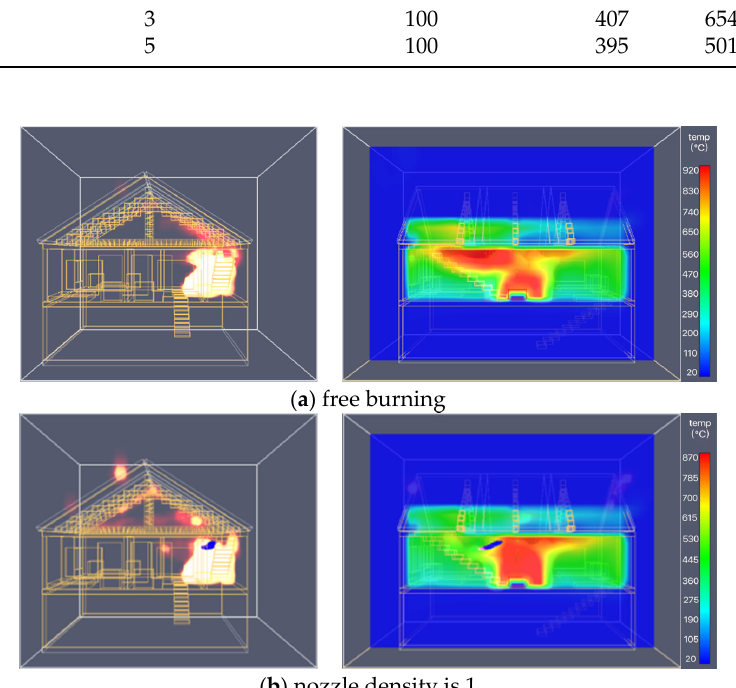
Figure 6. Temperatures measured by thermocouple A at different nozzle densities.